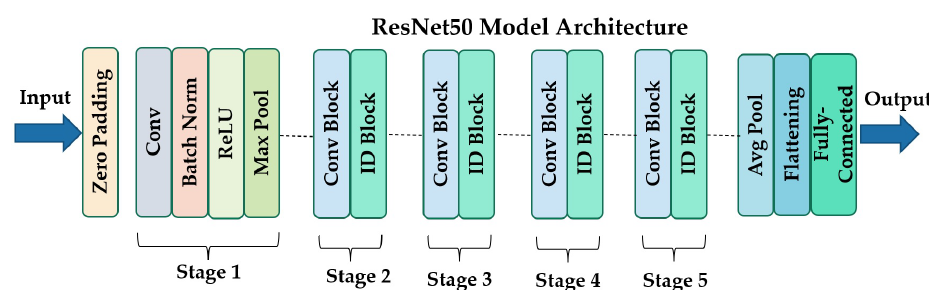
Figure 4. ResNet50 model architecture.